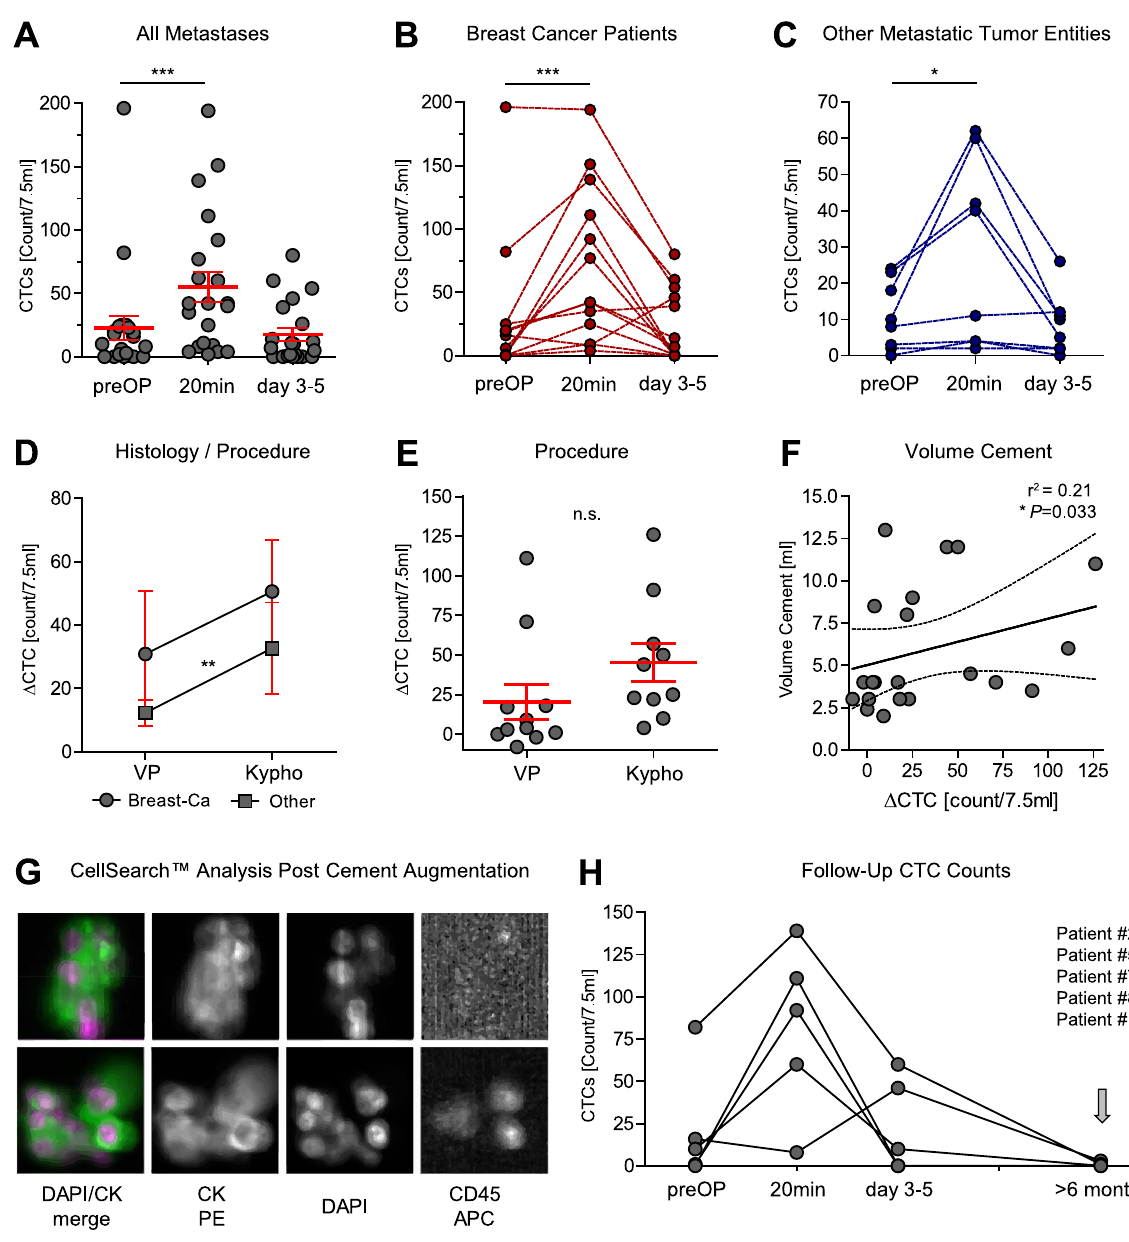
Figure 2. ( A – C ) Circulating tumour cell (CTC) counts in 7.5 ml of blood before (preOP), 20 minutes after and on day 3–5 after cement augmentation. P -values were determined by generalized linear mixed (GLM)-effect model for repeated measures. Bars and error depict mean CTC count and SE. Subgroup analysis shows connected CTC count course for individual patients, separated for breast-cancer ( B ) and other metastatic tumour entities (C) which are detectable by CellSearch ™ . ( D ) Increase of CTC counts (CTC preOP − CTC 20min = ∆ CTC/7.5 ml) compared between kypho- (Kypho) and vertebroplasty (VP) according to histology. ( E ) CTC increase ( ∆ CTC/7.5 ml) by procedure (Vertebro- (VP) vs kyphoplasty (Kypho), bars show mean and SE). Statistical values determined by a GLM-effect model for repeated measures. ( F ) Correlative comparison of CTC increase ( ∆ CTC) with applied cement volume [ml] with linear regression curve fit and 95% CI analysed by Spearman correlation. ( G ) Representative CellSearch ™ analysis two showing CTC clusters of two patients and individual K-PE, DAPI, CD45, as well as merged DAPI/K pictures. ( H ) CTC counts course of five patients with long-term follow-up blood draws ( > 6